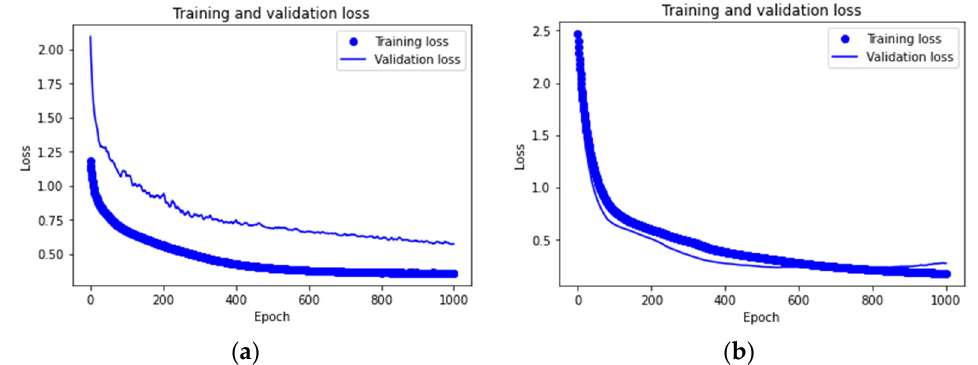
Figure 3. Training and validation losses for ( a ) curing time of NCA and ( b ) shear strength of NCA. The calculated MAEs and MAPEs for training and validation datasets for curing time and shear strength models were shown in Table 2. The MAEs for the training and valida- tion datasets for the curing time model were 1.57 s and 1.84 s, respectively. The MAEs for the training and validation datasets for the shear strength were 6.08 MPa and 6.13 MPa, respectively. The MAPEs for the training and validation datasets for the curing time were 24.7 % and 25.4 %, respectively. The MAPEs for the training and validation datasets for the shear strength were 18.8 % and 22.5 %, respectively. Table 2. Mean absolute error (MAE) and mean absolute percentage error (MAPE) of the trained models .